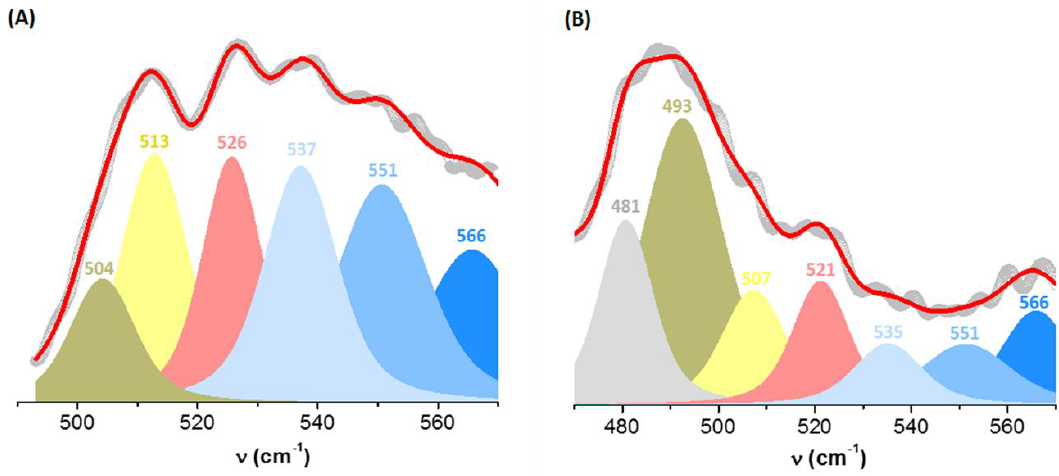
Figure 6. Deconvolution of the Raman bands in the spectral range corresponding to the ν (S–S) vibrations: ( A ) free BSA (day 1, R 2 = 0.995), ( B ) BSA adsorbed onto gold nanoparticles (day 40, R 2 = 0.994); the experimental spectra are depicted by grey dots, the convoluted spectra by red lines and the individual component functions are in color.